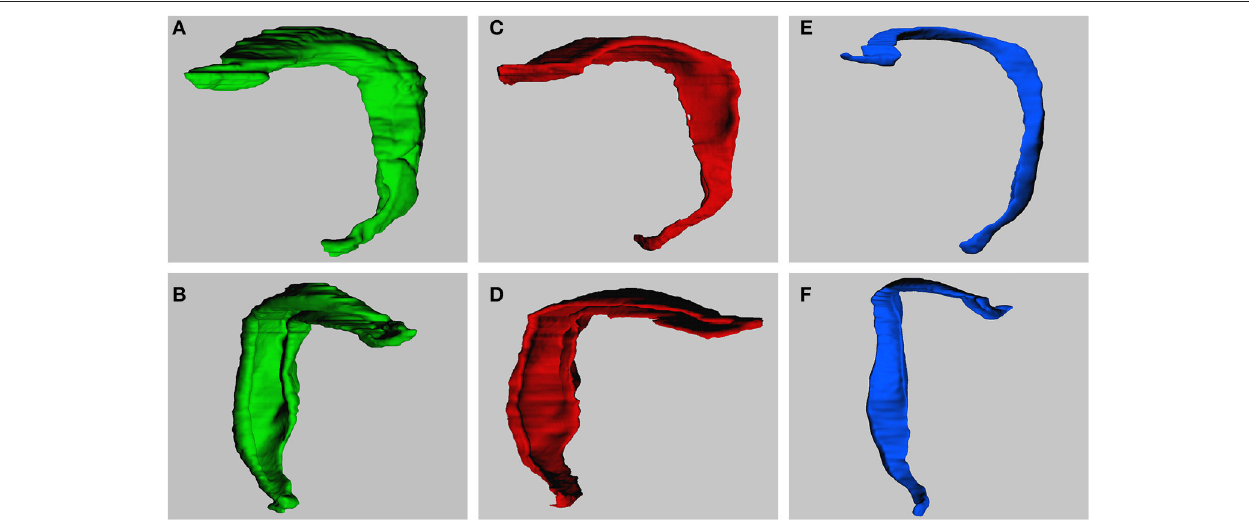
FIGURE 4 | 3-Dimensional models of dentate gyrus layers. Models are constructed based on the horizontal series of real sections. Models represent the dentate molecular layer (A,B) , the granule cell layer (C,D) and hilus (E,F) . Views are from medial to lateral (A,C,E) or into the concavity of the dentate layers from anterior to posterior ( B,D,F ; slight variations between exact